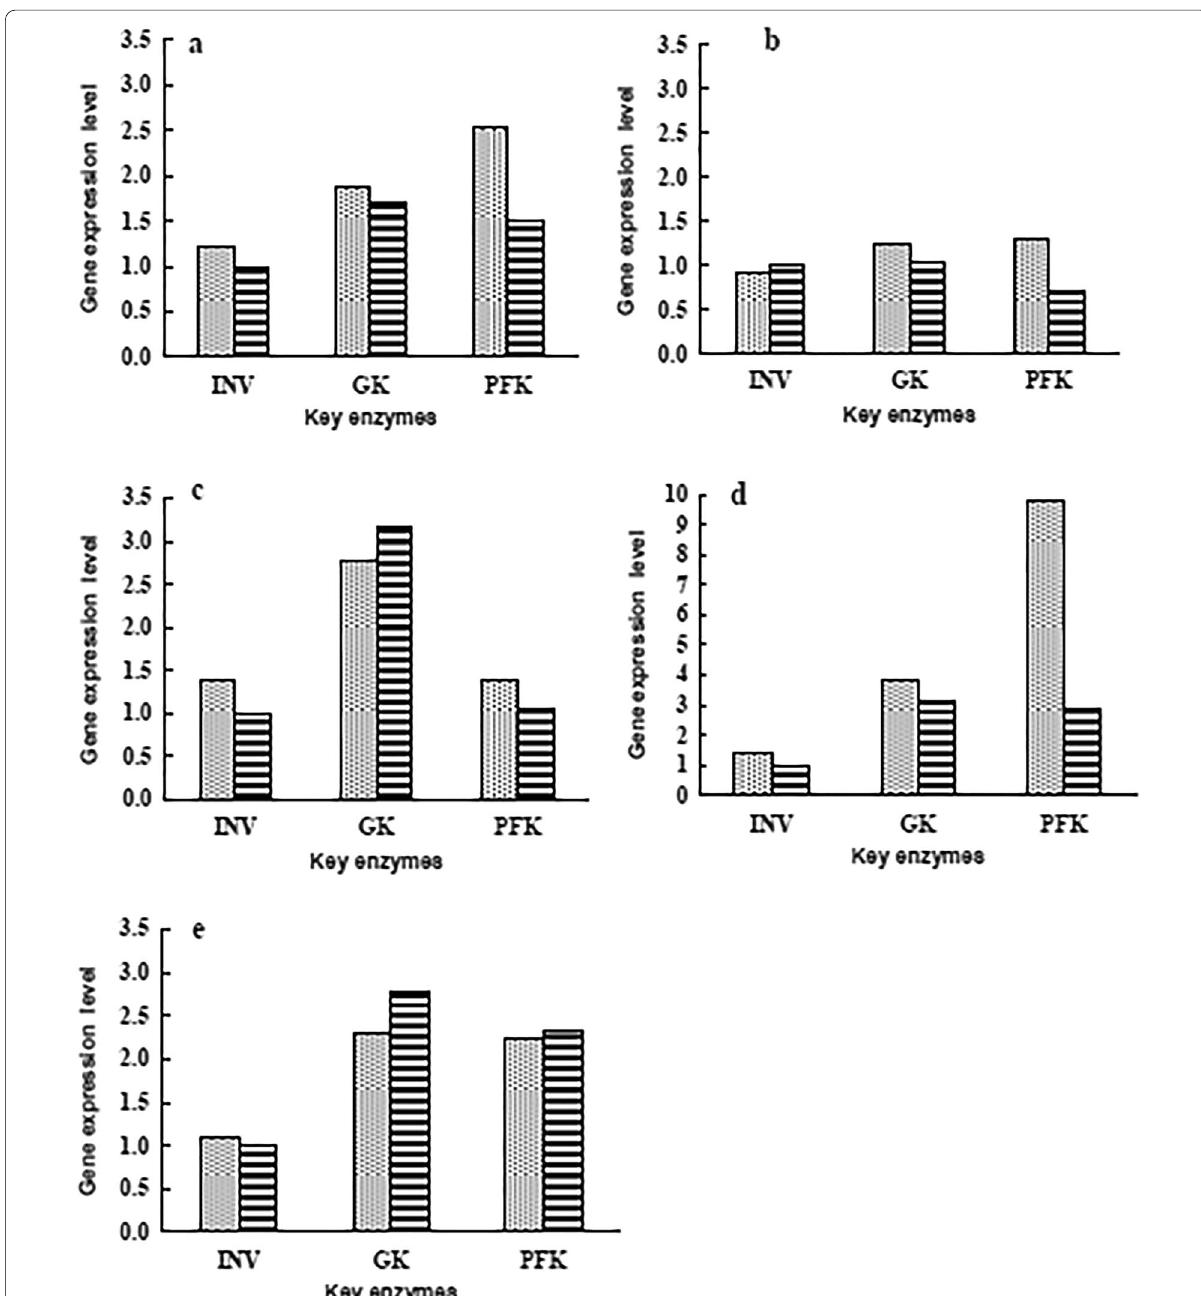
Fig 8 RT-qPCR analysis of key enzyme gene expression under pH control and non-pH control . INV, invertase; GK, glucokinase; PFK, phosphofructokinase. a 4 h; b 8 h; c 12 h; d 16 h; e 24